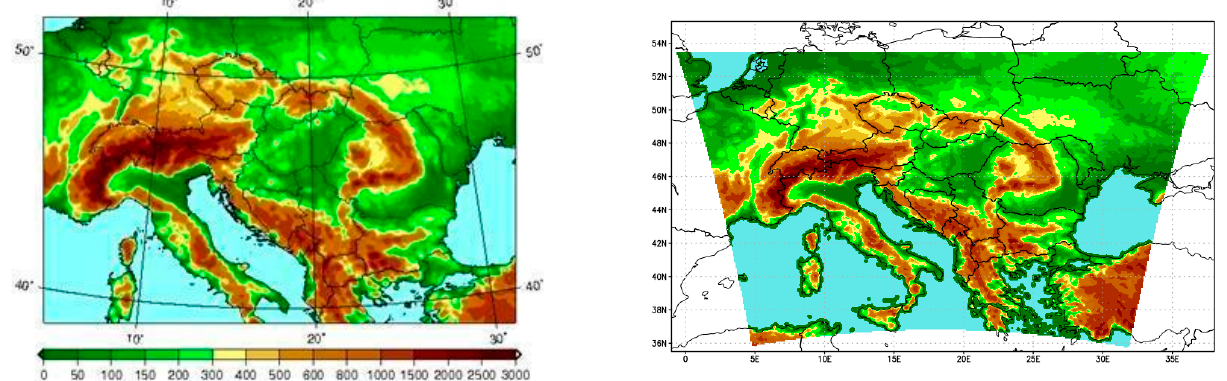
Figure 1. Integration domain and topography of the ALADIN5.2 (left) and REMO2015 (right) model simulations, both with a 10 km resolution.